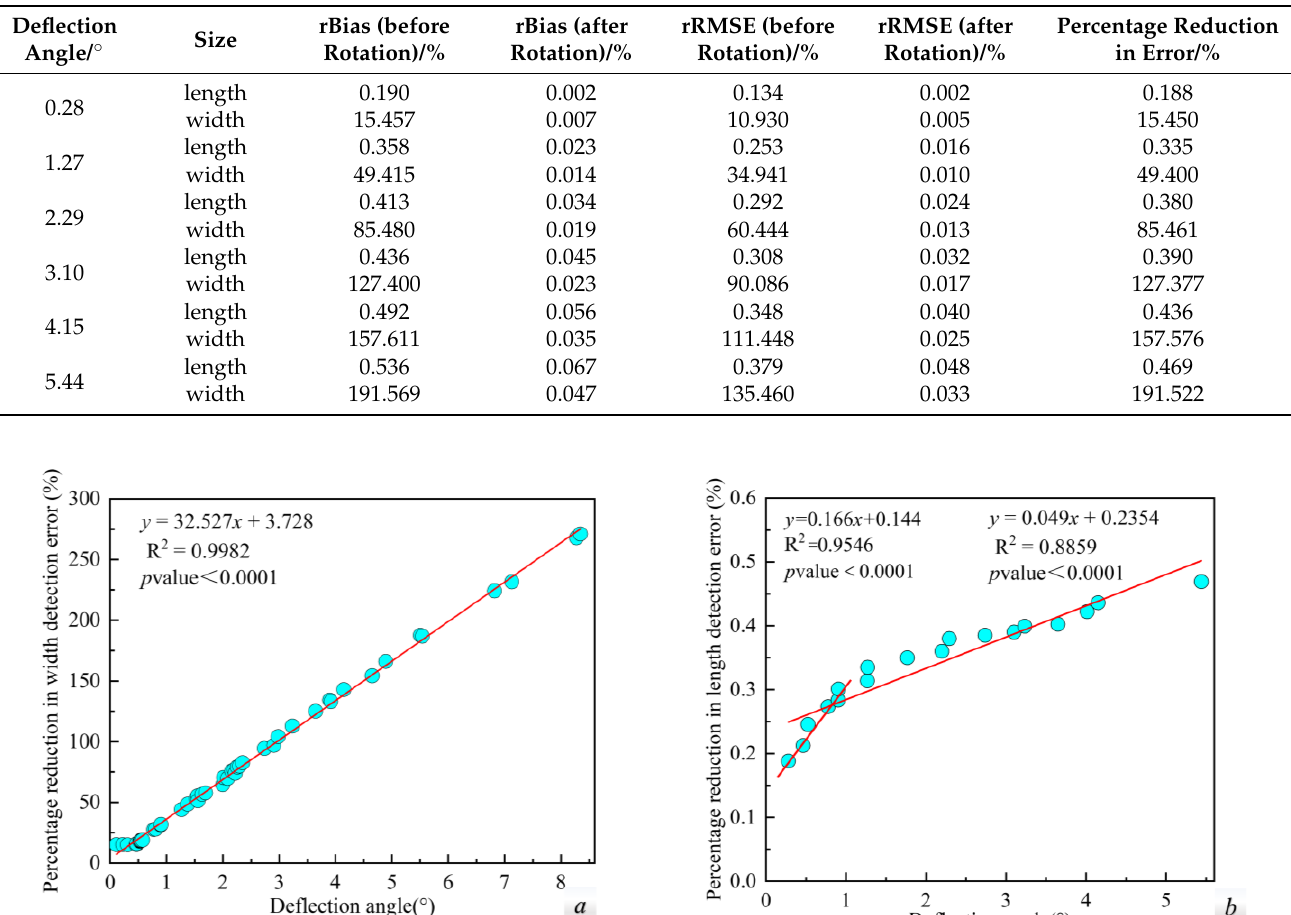
Table 2. Comparison between the measurements based on machine vision and the actual measure- ments.